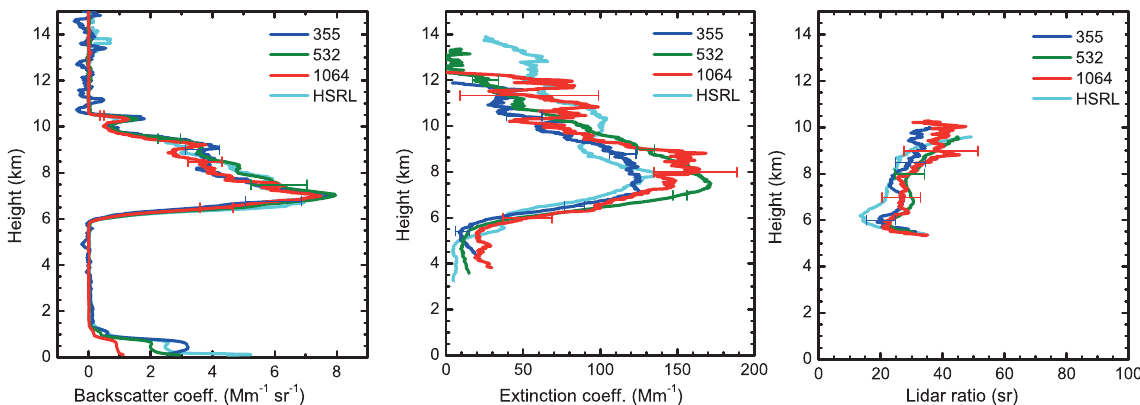
Figure 3. Triple-wavelength Raman lidar observation of cirrus particle backscatter coefficients (left), extinction coefficients (center), and corresponding lidar ratios (right). The 2h lidar measurement shown in Fig. 2 was taken at Leipzig on 12 October 2015, 18:20–20:20UTC. In addition to the Raman lidar profiles, HSRL profiles (532nm) are shown. Error bars show the uncertainty caused by signal noise in the case of the Raman lidar profiles. Uncertainties caused by atmospheric input parameters (temperature and pressure profiles) are small (in the case of extinction typically 5Mm − 1 , in the worst case up to 10Mm − 1 ) (Ansmann et al.,